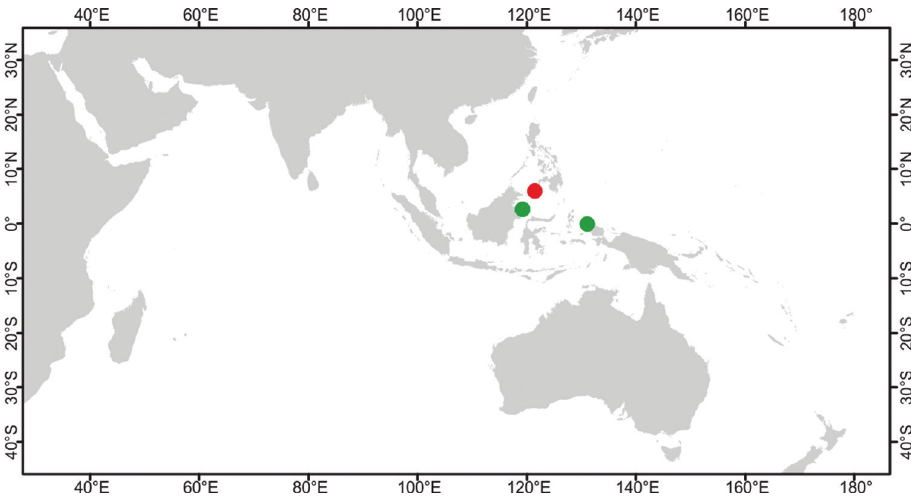
Figure 13. Distribution of Cinachyrella paterifera . Red dot: type locality, Tetilla (Cinachyrella) paterifera Wil- son, 1925, Sibutu Island, Philippines. Green dots: Indonesian localities where the species was collected